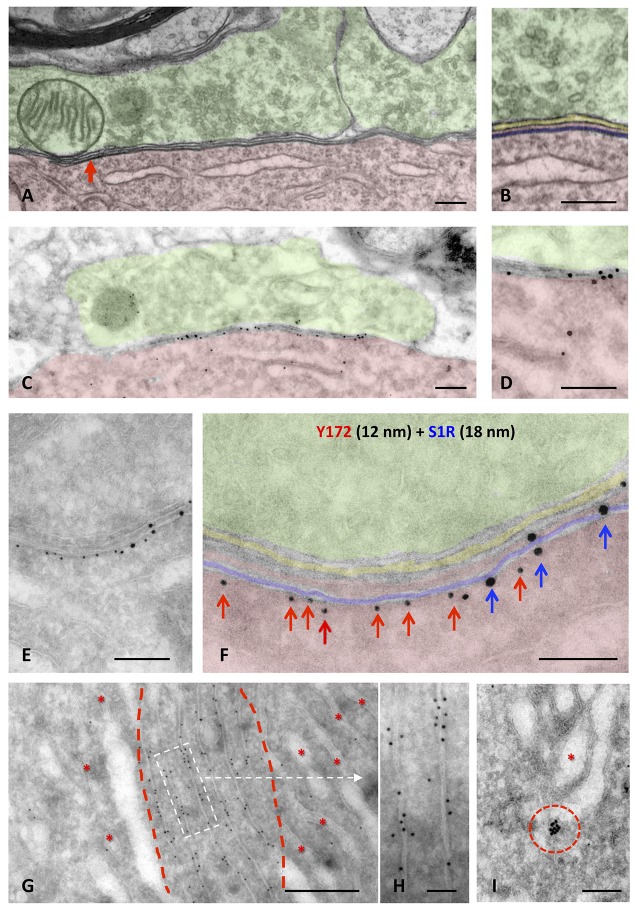
Ultrastructural localization of Y172 immunogold staining in the spinal cord and hypoglossal MNs of adult (P75) mice. (A,B) A C-bouton on a spinal cord MN cell body (shaded in red) observed by the electron microscopy after conventional processing; presynaptic terminals (shaded in green) were filled with small clear synaptic vesicles and some mitochondria. Adjacent and closely associated with the postsynaptic membrane, a flattened cistern of the endoplasmic reticulum (ER; shaded in blue), corresponding to the subsurface cistern (SSC), was observed (more detailed in B); the intersynaptic extracellular space is shaded in yellow. (C,D) A C-bouton detected in an ultrathin cryosection of an MN after double immunolabeling with different sizes of nanogold particles depicted at middle magnification. To facilitate the identification of C-bouton synaptic organization in a less structurally defined cryosection, compare (C,D) with (A,B). Note also the accumulation of gold particles representing Y172 immunoreactivity at the postsynaptic region of the C-bouton (shaded in red). (E,F) A higher magnification image showing a double immunogold labeling of a C-bouton synaptic site using the Y172 antibody (red arrows) and an anti-S1R antibody as SSC marker (blue arrows), visualized with 12-nm and 18-nm particles, respectively. To facilitate the localization of the immunolabeling, the coloring of the synaptic subcompartments in (F) is the same as that in (A,B); Y172 antibody immunoreactivity was located on the outer surface of SSC membrane (red arrows) and clustered separately from S1R immunoreactivity (blue arrows). (G,H) Y172 immunoreactivity was also associated with stacked membrane sheets of the ER (delimited by red dashed lines); other ER regions containing less compact cisterns (*) were devoid of labeling. (H) A detailed image of the ER (delimited by the white dashed-line rectangle in G) immunolabeled with the Y172 antibody revealed that gold particles were mainly associated with the external surface of the ER membranes. (I) Y172 immunolabeling was also observed in vesicles (delimited by the red dashed circle) adjacent to the Golgi apparatus (*). Scale bars: A–F = 200 nm; G = 500 nm; H,I = 100 nm.